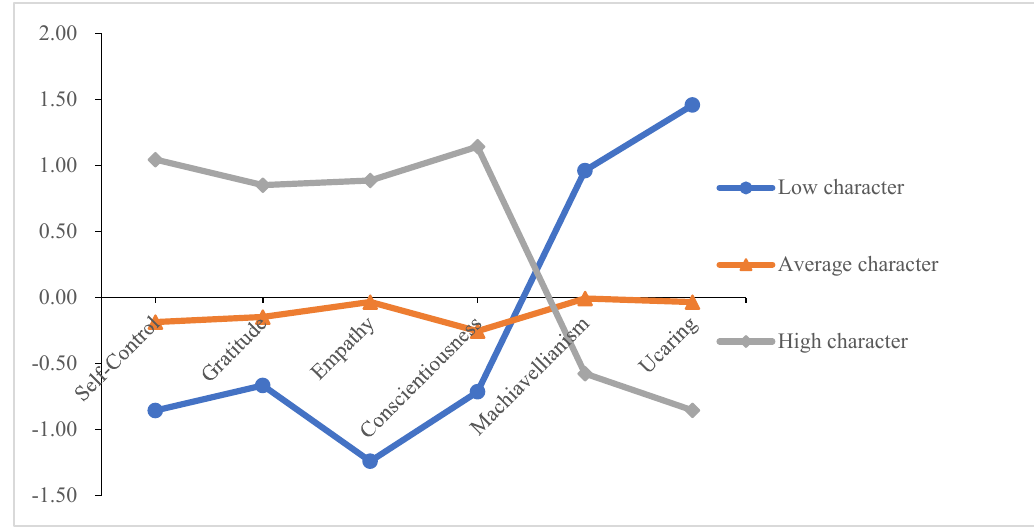
Figure 1. Moral character latent profile model.